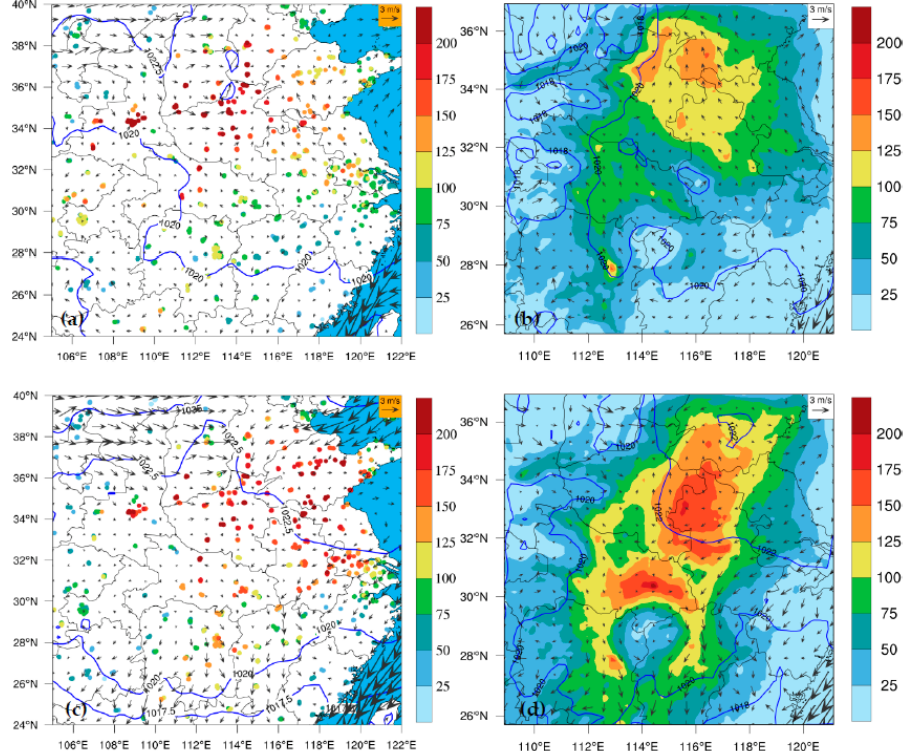
Figure 2. Spatial distribution of (left panel) observed and (right panel) simulated near-surface PM 2.5 concentrations (color dots (left panel), color contours (right panel), μ g/m 3 ), and 10 m wind vectors (m·s − 1 ) averaged ( a , b ) over 14–17 January and ( c , d ) over 19–22 January in 2018. Blue lines indicate sea level pressure (hPa). Blue area denotes the Pacific Ocean in the left panels.